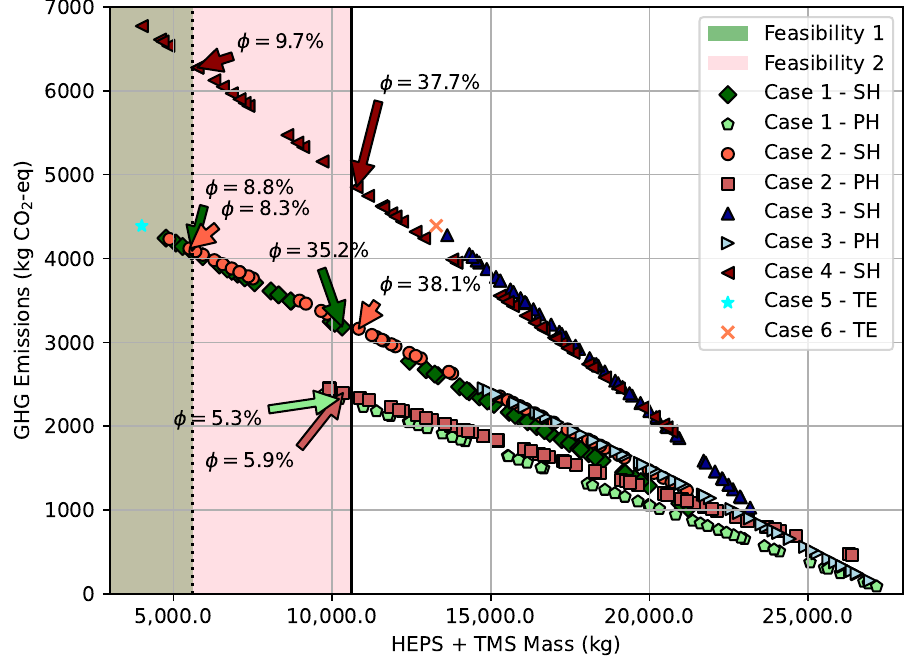
Figure 17. Resulting Pareto-optimal solutions. Feasibility regions 1 and 2 represent limit masses for a reference propulsive system (including fuel) without and with considering payload, respectively. The acronyms SH, PH and TE stand for series-hybrid, parallel-hybrid and turboelectric, respectively. Cases 3 and 1 correspond, respectively, to optimistic scenarios with and without accounting for the heat dissipated by the combustion engine. Cases 2 and 4 are pessimistic scenarios, considering sustainable aviation fuel and Jet-A, respectively. The arrows indicate the hybridization factors ( φ ) closest to the feasibility